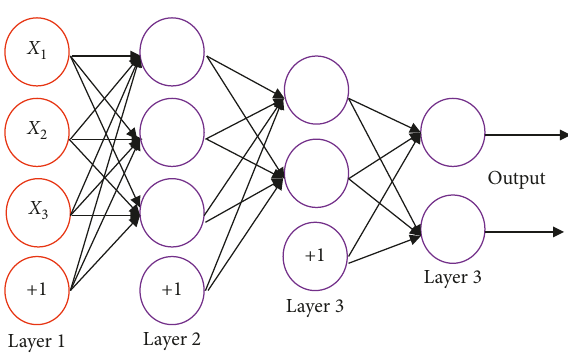
Figure 1: Multilayer neural network